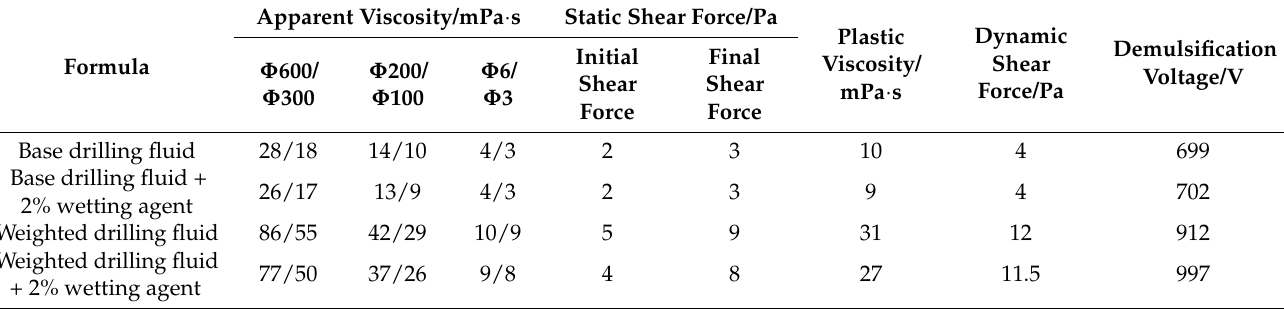
( a ) ( b ) Figure 5. Optimization test of plugging materials (( a ) Particle size distribution of plugging materials; ( b ) Pressure transmission evaluation of oil-based drilling fluid). Table 4. Effect of wetting agent on drilling fluid rheology.